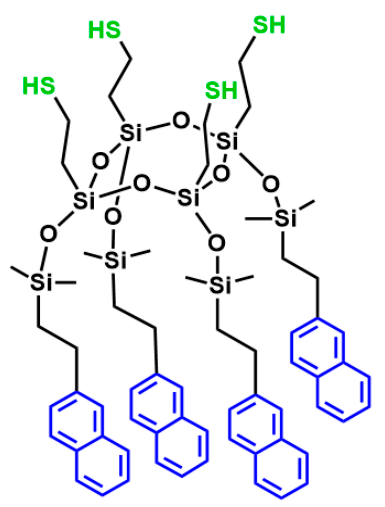
Figure 6. Janus T 4 tetrapod in an all- cis configuration ( J3 ).